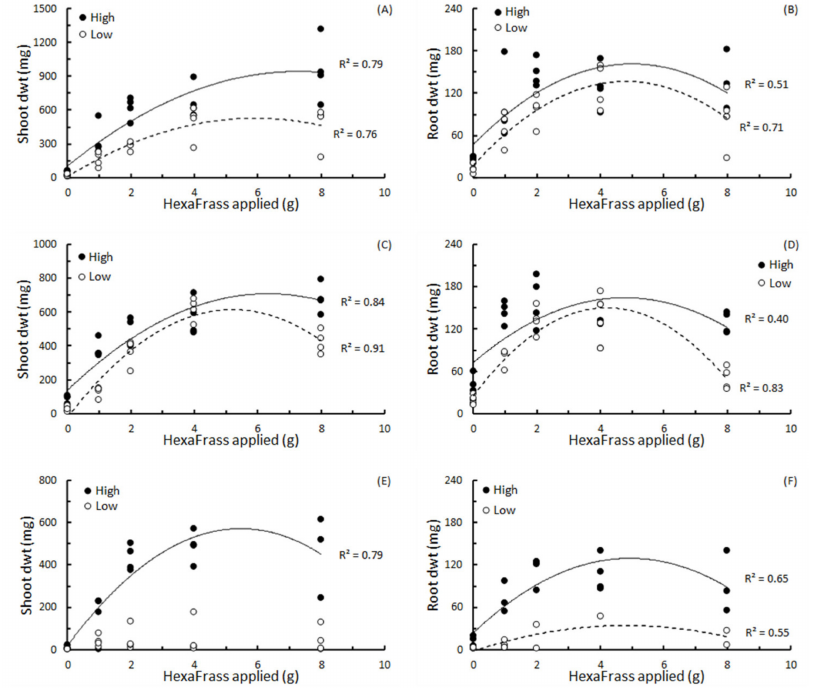
Figure 2. The relationships between shoot and root dry weight and amount of HexaFrass™ (g) applied to high or low nutrient potting mix for ( A , B ) basil, ( C , D ) lettuce and ( E , F ) parsley. R 2 values produced from fitting polynomial order 2 regression